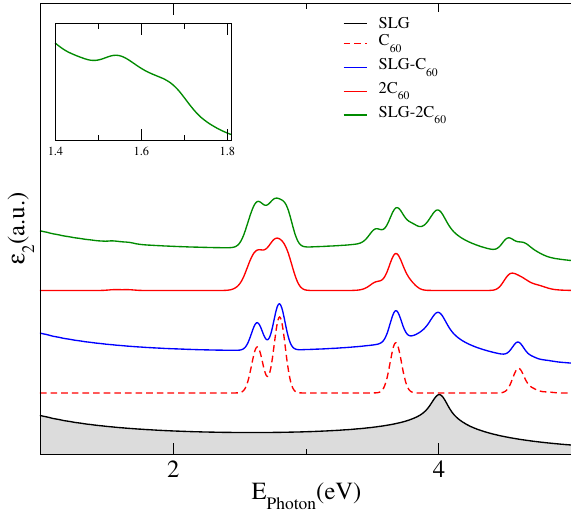
Figure 2. Imaginary part of the dielectric constant as a function of the photon energy for a pristine single layer graphene ( black line), isolated C 60 (red dashed line) and 2C 60 (red line) fullerenes and, for the SLG–C 60 (blue line) and SLG–2C 60 (green line) hybrids. The insert shows a zoom of the imaginary part of the dielectric constant of SLG–2C 60